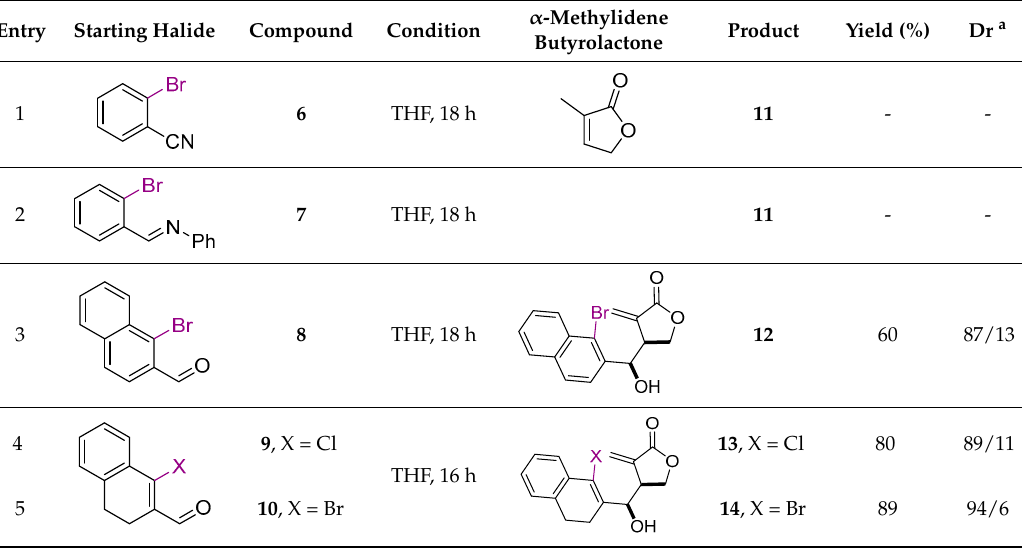
Table 2. Barbier reaction on substrates 6 to 10 .